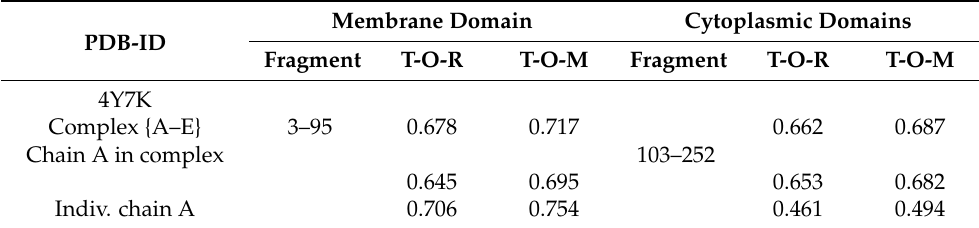
Table 3. Characteristics of the mechanosensitive channel—MscS (PDB ID-4Y7K) by the values of parameter RD on the specified domains for T-O-R and T-O-M relations. Top line designates a status of the complex composed of 5 chains regarded as a structural unit. Complex {A–E}—status of domain build by five domains representing each chain. Chain A in complex—the status of the domain regarded as a part of a complex composed of 5 domains, Individ chain A –status of the domain specified as a separate one in the individual